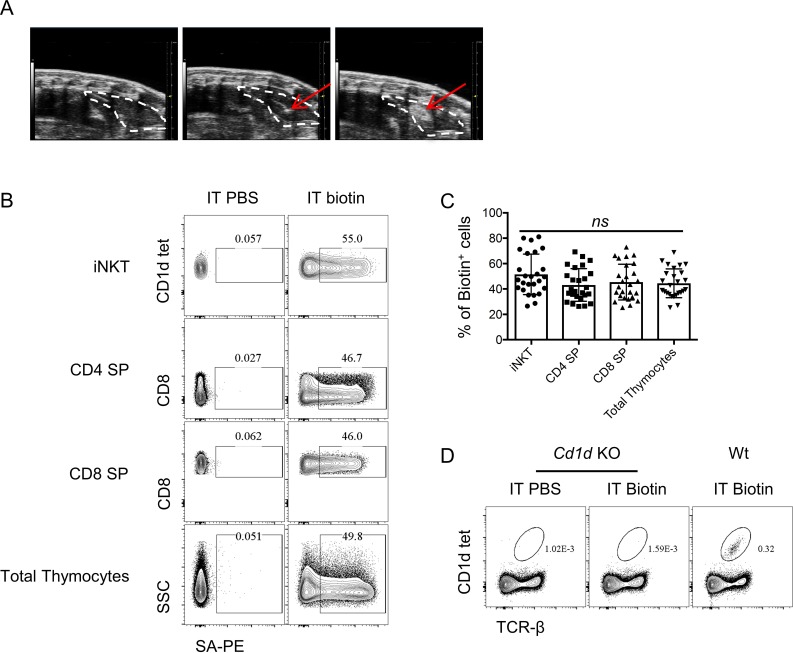
Ultrasound imaging guided intra-thymic injection.(A) Representative ultrasound image of mouse chest area, the thymus is outlined by white dotted line (left column), the red arrow indicates the needle tip in thymus before injection (middle column), after injection the red arrow indicates the injected NHS-biotin contained in the thymus (right column). (B) Representative flowcytometry profile and (C) frequency of biotinylated cells revealed by streptavidin-PE staining in various cell populations (iNKT, CD4 SP, CD8 SP and total thymocytes) in the thymus 24 hr later after intra-thymic injection of PBS or NHS-biotin. Data are pooled from six independent experiments with 2–6 mice in each. ns, not significant, p>0.05 (one-way ANOVA). Each symbol represents an individual mouse; Mean ± SD. (D) Representative flowcytometry profile of CD1d tetramer staining in thymocytes of Cd1d KO or Wt mouse received intra-thymic injection of PBS or NHS-biotin.